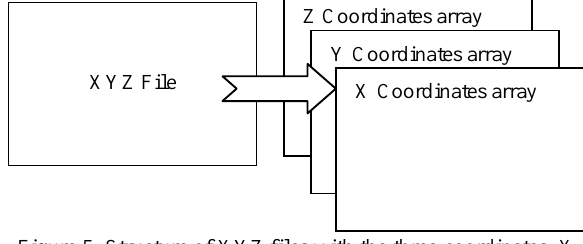
Figure 5: Structure of XYZ files with the three coordinates: X, Y and Z.